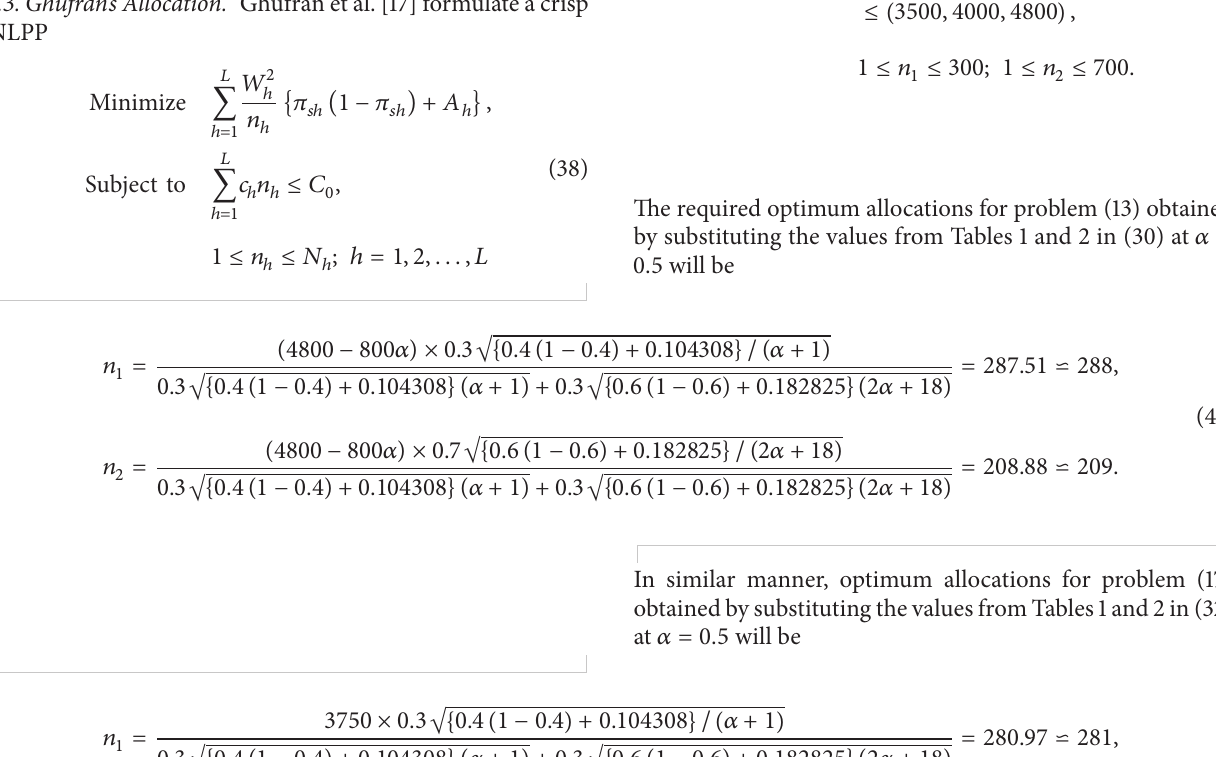
7.3. Ghufran’s Allocation. Ghufran et al. [17] formulate a